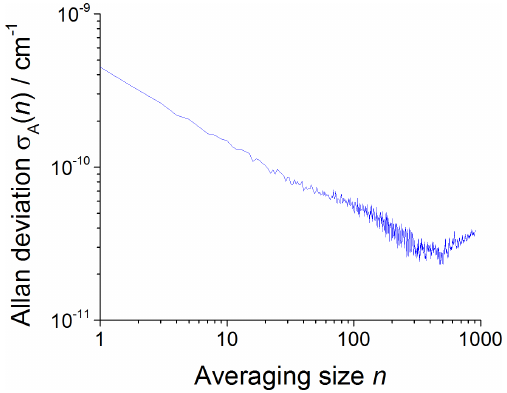
Figure 5. An example of the Allan–Werle deviation plot (the plot of the square root of the Allan–Werle variance) of the absorption coefficient at 7488cm − 1 in the absence of CH 3 O 2 and the presence of a typical acetone concentration of 8 . 8 × 10 14 moleculecm − 3 at 1000mbar against the number of ring-down events averaged, n . For S/N = 2, the minimum detectable absorption coefficient for a sin- gle ring-down measurement is 4 . 5 × 10 − 10 cm − 1 , which decreases to a minimum of 2 . 89 × 10 − 11 cm − 1 after n = 500 (requiring 77s at an acquisition rate of